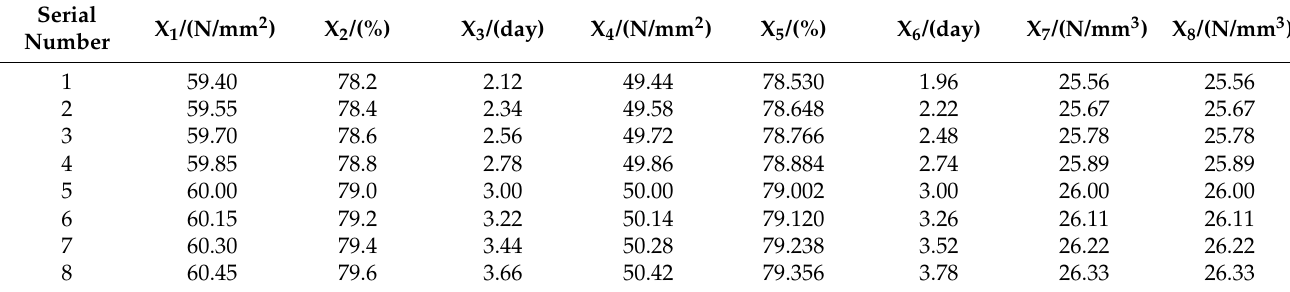
Table 2. Sample points based on uniform design.